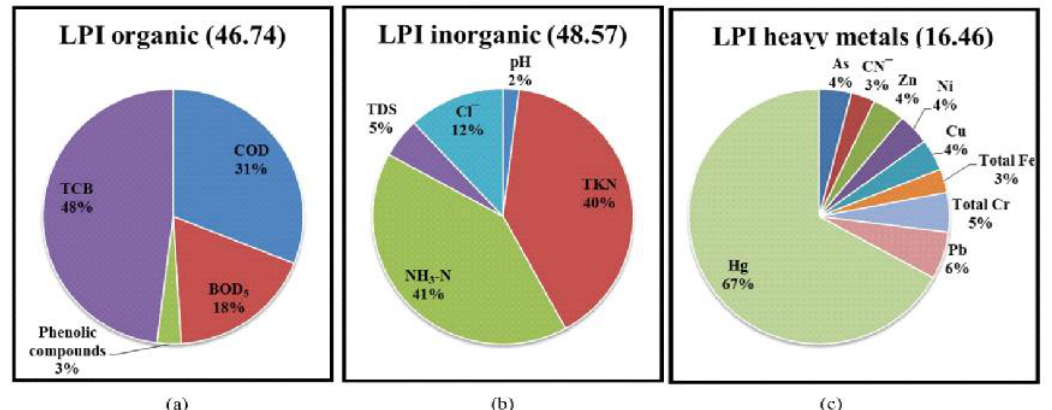
Fig. 3: Percentage distribution of the components of (a) LPI organic, (b) LPI inorganic and (c) LPI heavy metals for the closed dumping ground at Dhapa,